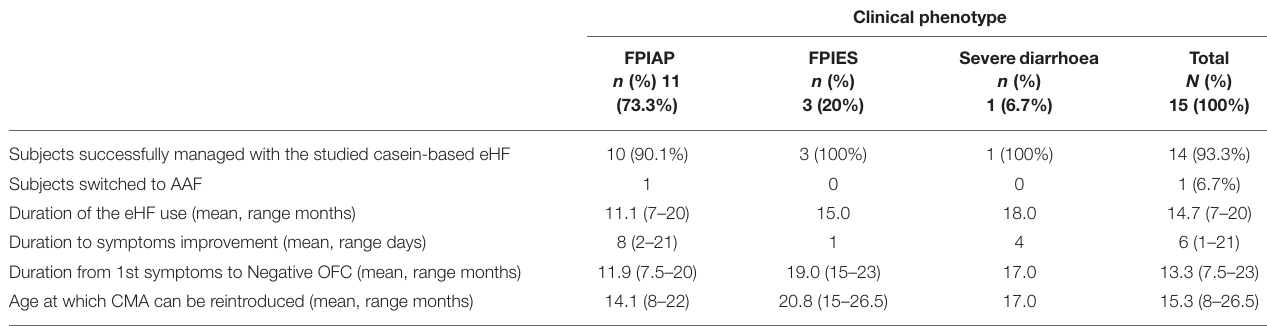
TABLE 2 | Clinical outcomes after the nutritional management with the